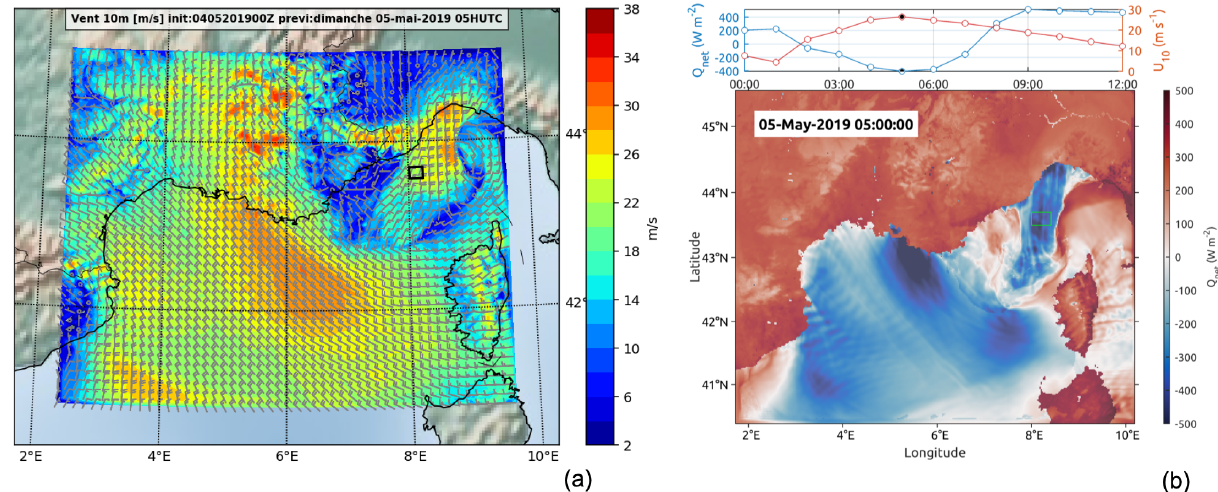
Figure 4. Results of the wind situation on 5 May (WRF model WRF-ARW v4.2.1). The black and green squares identify the TSG region of interest sampled 1d after the storm. Panel (a) presents the wind intensity at 10m on 5 May at 05:00UTC. Panel (b) shows the heat flux on 5 May at 05:00UTC (bottom subpanel) and the temporal distribution of wind intensity and heat flux on 5 May between 00:00 and 12:00UTC (top subpanel) in the area enclosed by the green